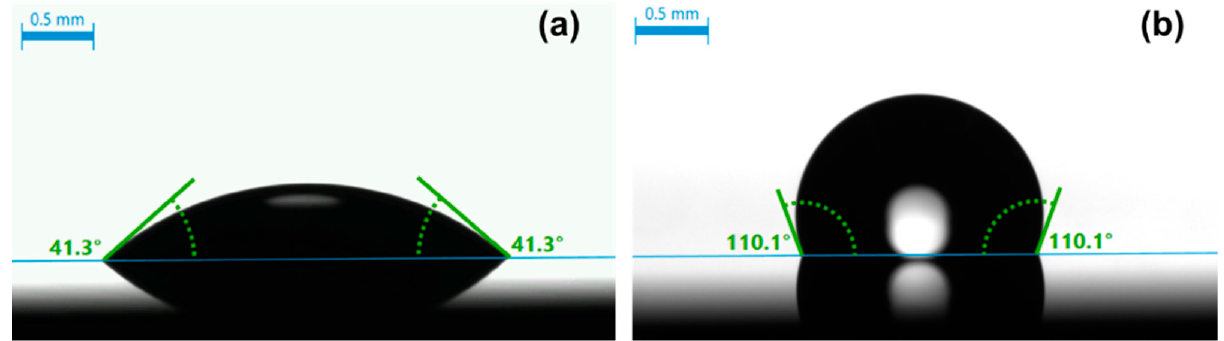
Figure 1. Optical images showing a static water contact angle on a bare SiO 2 substrate ultrasonically cleaned in methanol ( a ) and on OTMS SAMs formed on a SiO 2 substrate subjected to UV/ozone treatment ( b ).